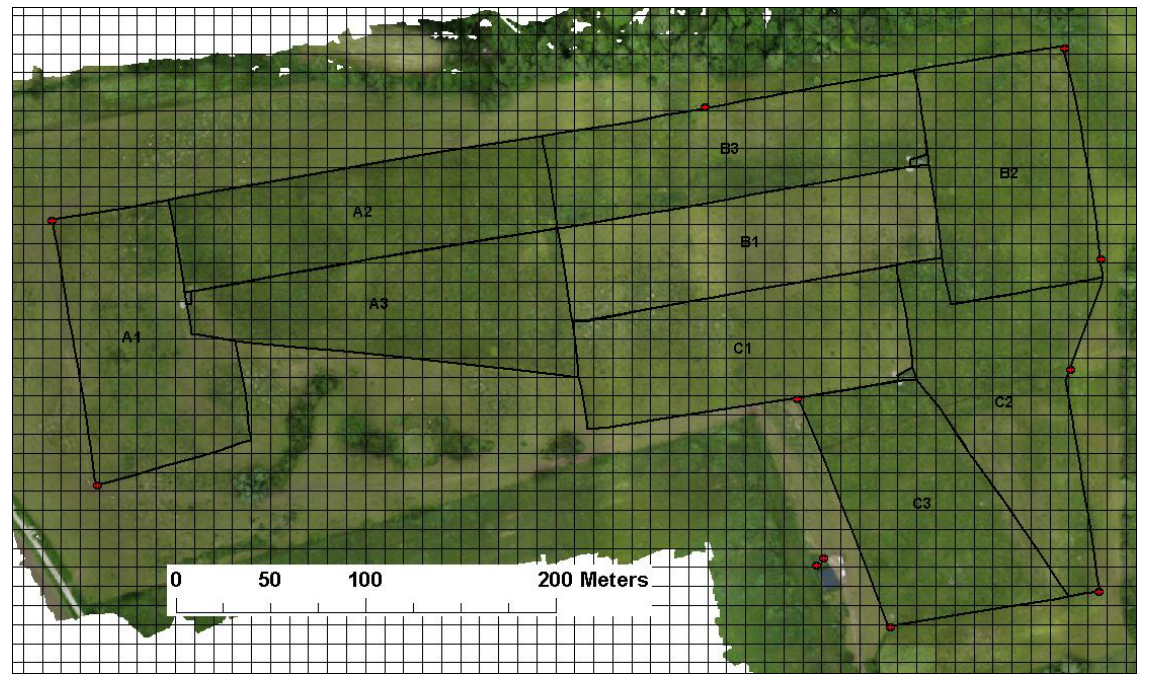
Figure 1 . UAV-derived orthophoto of the grazing experiment “FORBIOBEN” and the 10 m polygon grid. The pasture